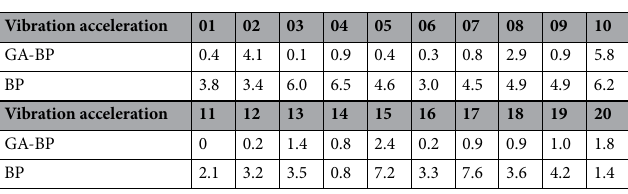
Table 5. Prediction error of motor vibration